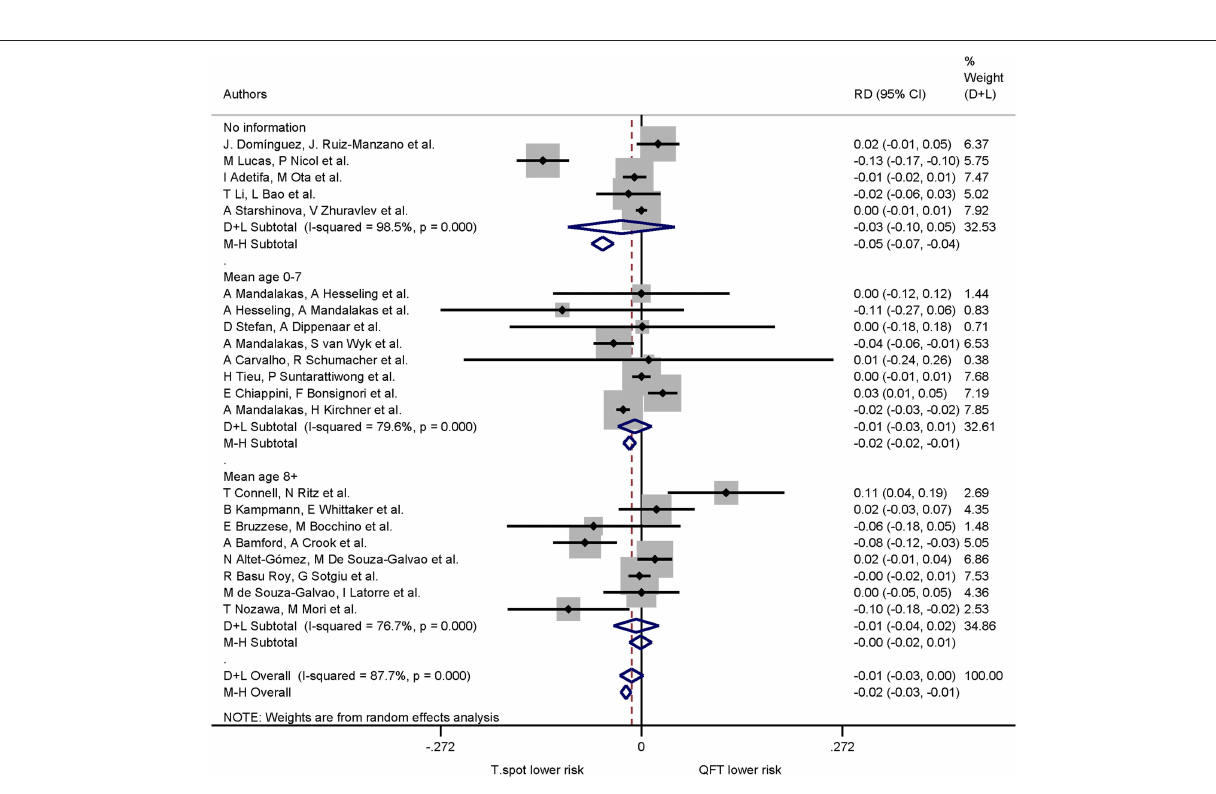
Frontiers in Pediatrics |